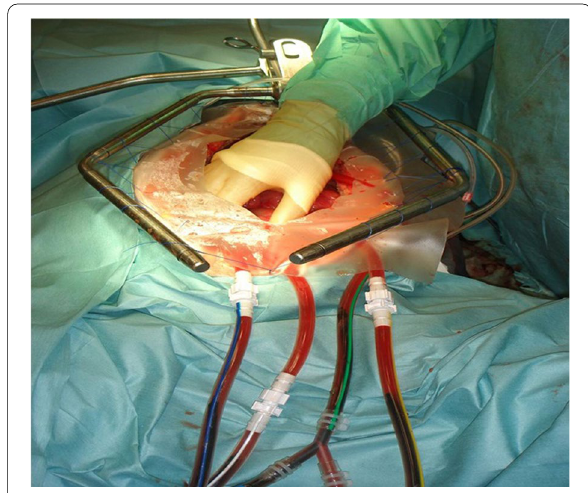
Fig. 10 Photograph of hyperthermic intraperitoneal chemotherapy (HIPEC)